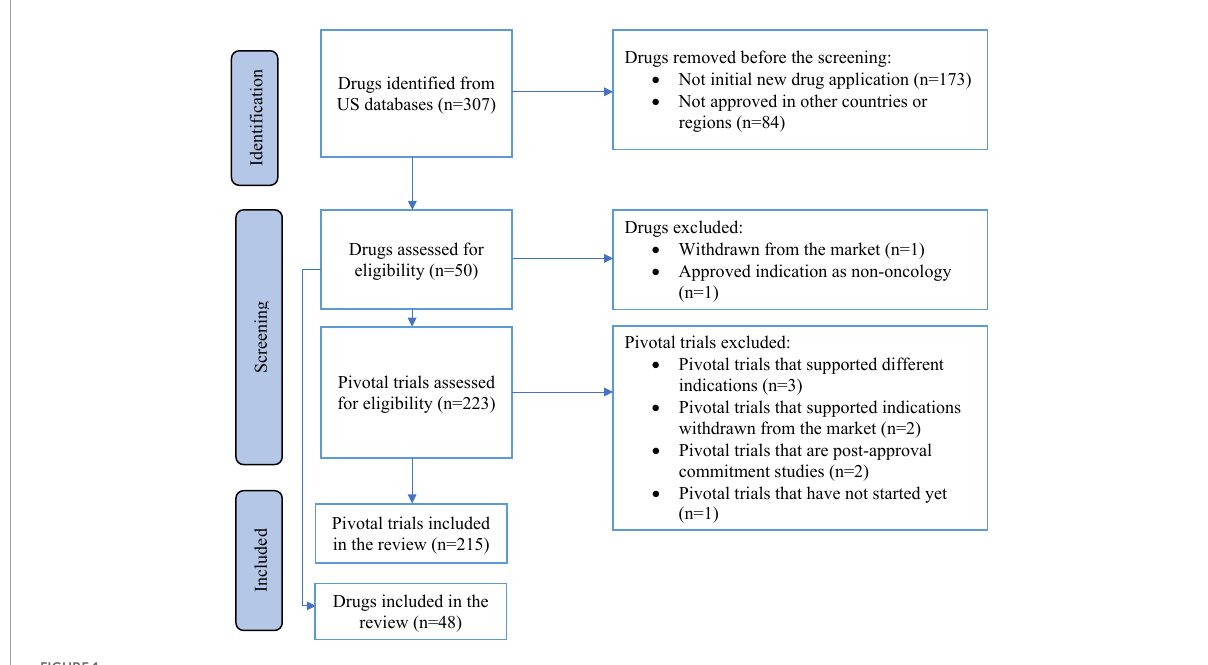
FIGURE1 Flow diagram for the identification of studies.